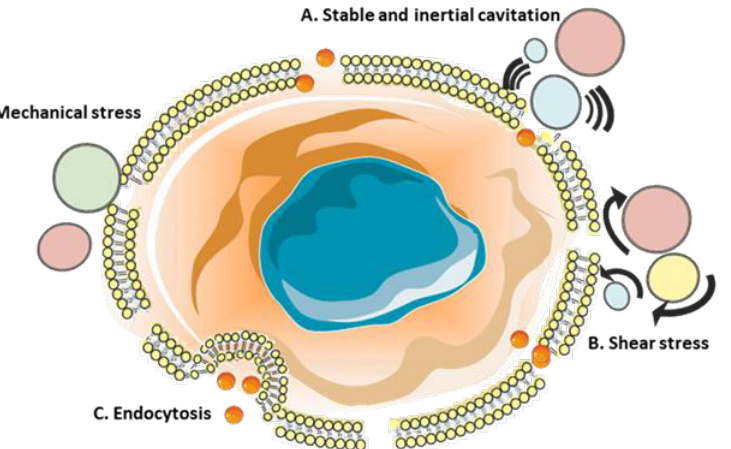
Figure 4. Mechanisms involved in sonoporation of the cell membrane after ultrasounds application: ( A ) cavitation of microbubbles and gas bodies in surrounding medium; ( B ) shear stress evoked by acoustic streaming and medium flow during cavitation; ( C ) endocytosis; ( D ) mechanical stress triggered by the cavitating agents [253].